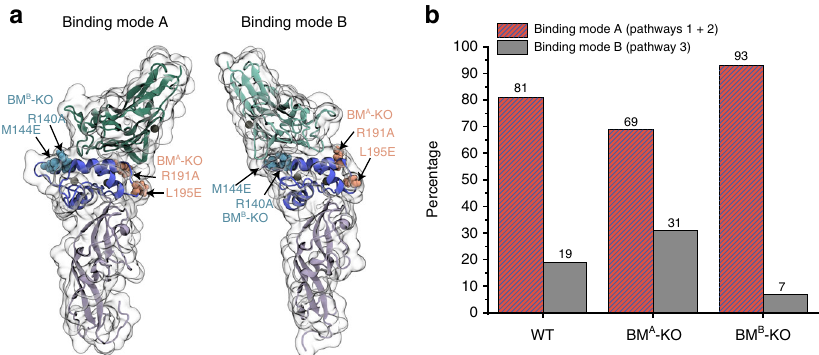
Fig. 3 SMFS measurements of XMod-Doc-binding mode mutants. a Arginine 191 and leucine 195 on Doc were mutated to alanine and glutamic acid, respectively, to disrupt their interaction with Coh in binding mode A. Arginine 140 and methionine 144 were mutated to alanine and glutamic acid, respectively, to disrupt their interaction with Coh in binding mode B. b Percentages of the two binding modes measured with WT XMod-Doc, BM A -KO mutant, and BM B -KO mutant at 400nm/s pulling speed. The BM A -KO mutant preferentially populates binding mode B while the BM B -KO mutant preferentially populates binding mode